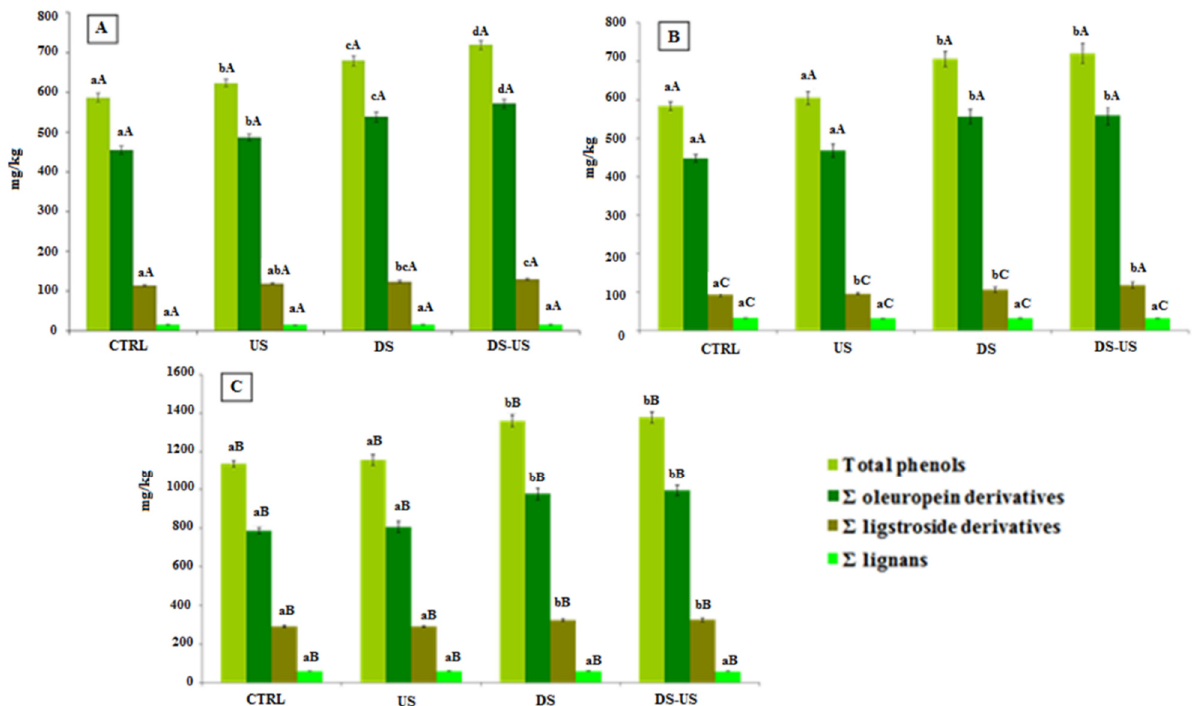
Figure 6. Phenolic composition (mg/kg) of Peranzana ( A ), Canino ( B ) and Coratina ( C ) EVOOs. Phenolic content was expressed as total phenols, oleuropein derivatives (sum of 3,4-DHPEA, 3,4-DHPEA-EDA, and 3,4-DHPEA-EA), ligstroside derivatives (p-HPEA, p-HPEA-EDA, and ligstroside aglycone), and lignans [sum of (+)-1-acetoxypinoresinol and (+)-pinoresinol]. The data are the mean values of the three samples analyzed in triplicate ± standard deviation. For each different cultivar, the values of each phenolic group with different lower-case letters are significantly different from one another ( p < 0.05). For each different test, the values of each phenolic group of the three cultivars with different upper-case letters are significantly different from one another ( p < 0.05). CTRL = control test, US = ultrasound test, DS = destoned test, DS-US = destoned-ultrasound test.